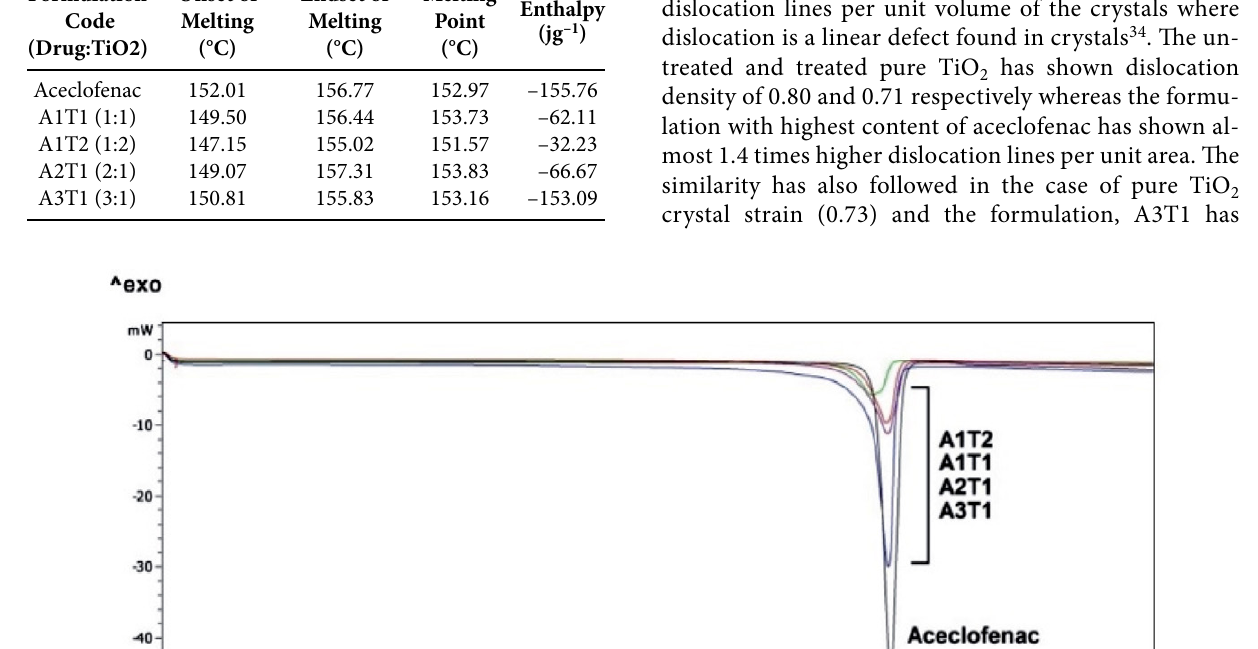
Table 1. Thermal behaviour of TiO 2 kneaded aceclofenac formula- tion Formulation